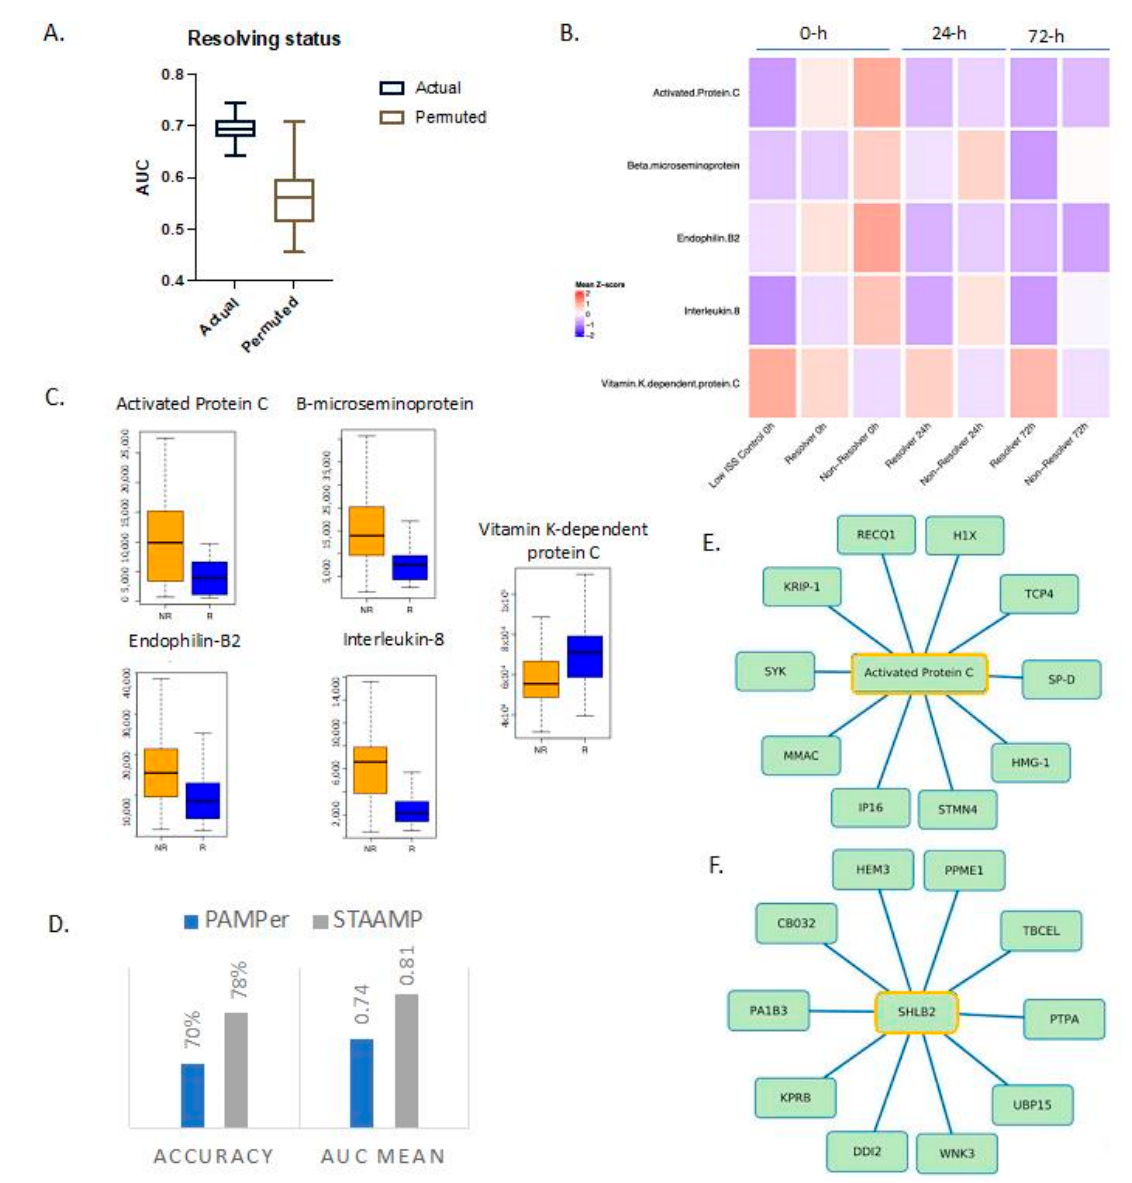
Figure 2. Proteomic markers predict resolution of critical illness based on ICU length of stay and time of death. ( A ) Actual and permuted LASSO AUC graph showing AUC of 0.74 for the levels of 5 proteins. ( B ) Heatmap of selected proteins for different outcomes based on time of death and ICU length of stay over time; 0, 24, and 72 h refer to time from emergency department admission. Low ISS controls n = 29, resolvers n = 25, non-resolvers n = 50. ( C ) Box plots of LASSO-selected features that are significantly different between resolvers and non-resolvers with raw value measurement. ( D ) Selected features from model run on PAMPer patients predict non-resolving status in a validation cohort (STAAMP clinical trial) with an AUC of 0.81 and an accuracy of 78%. ( E , F ) Correlation network between selected features and proteomic database at Spearman’s r = 0.70 showing direct associations (selected feature outlined in yellow). SHLB2 =